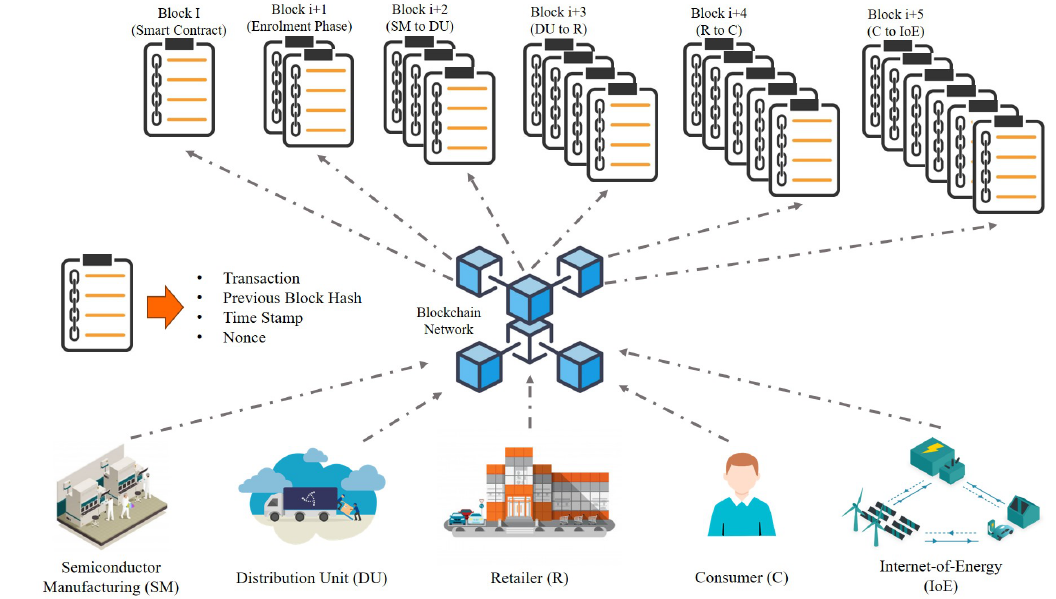
Figure 13. IC traceability from manufacturer to the end-user via PUF and